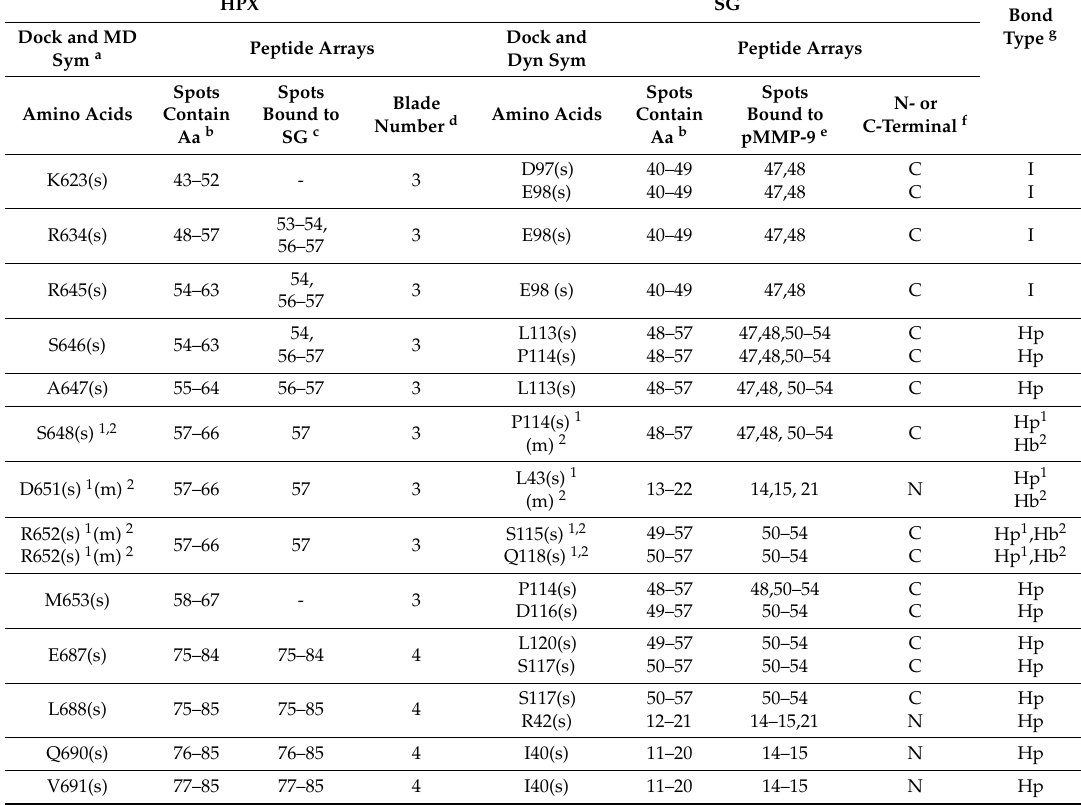
Table 3. Amino acid interactions between HPX and SG as seen in Model 2. Amino acid interactions between HPX and SG based on peptide arrays, docking, and MD simulations. HPX